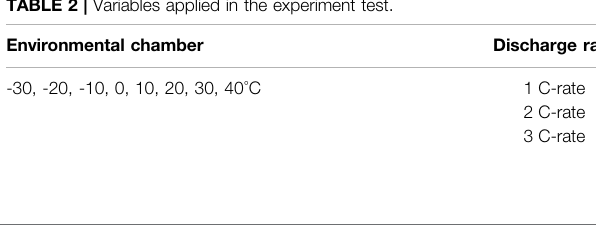
TABLE 2 | Variables applied in the experiment